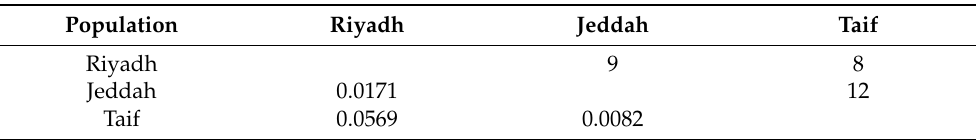
Table 6. Pairwise F ST estimates (below diagonal line) and predicted number of migrants (Nm, above the diagonal line) for the three house fly field